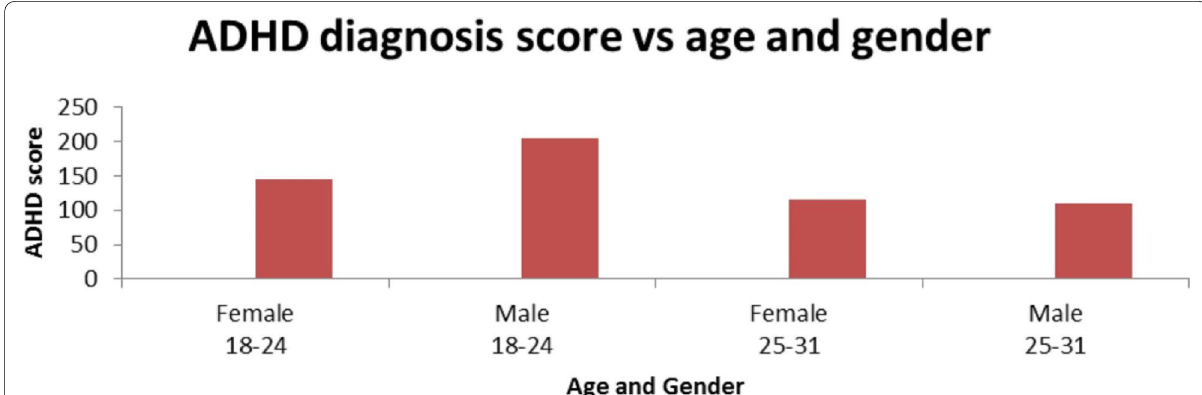
Fig. 1 Distribution of Attention-deficit/hyperactivity disorder score in different age groups and gender